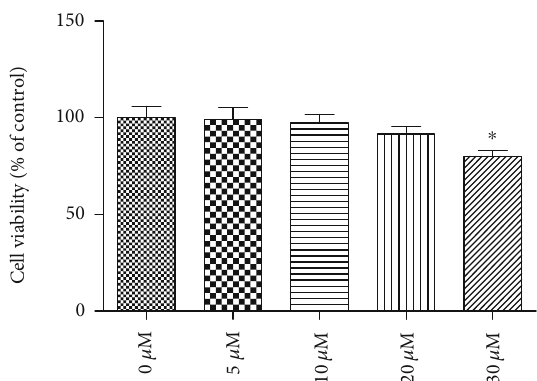
Figure 1: E ff ect of tangeretin on human RPE cell viability. The cells were incubated with di ff erent concentrations of tangeretin (0, 5, 10, 20, and 30 μ M) for 24h. The MTT assay was then performed to measure cell viability of human RPE cells. ∗ p < 0 : 05 vs. control group (0 μ